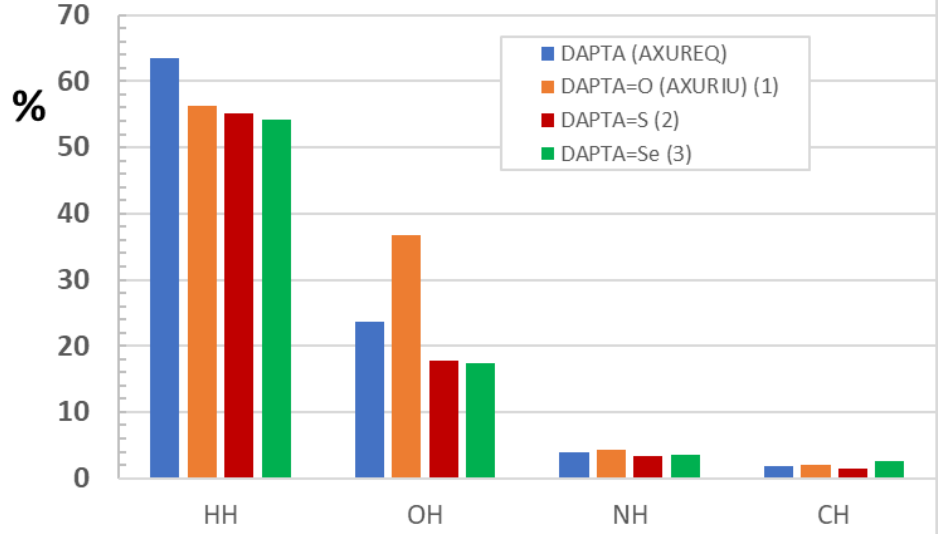
Figure 7. Plot of the percentage contribution of the diverse contacts to the total volume of the surface.